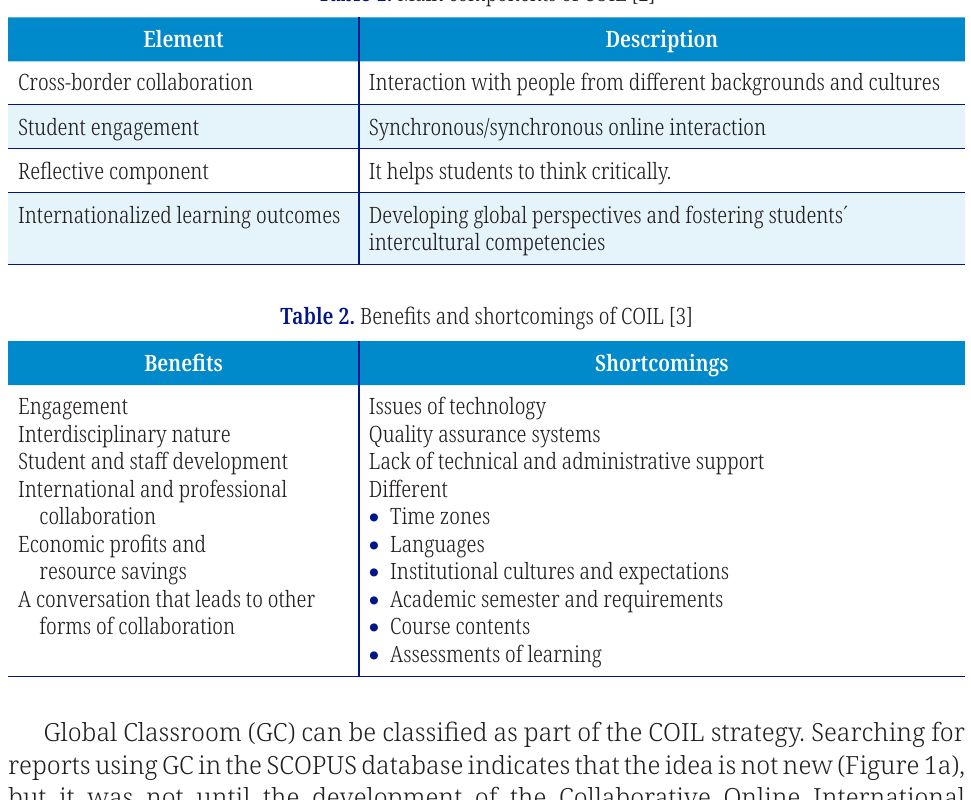
Table 1. Main components of COIL [2]